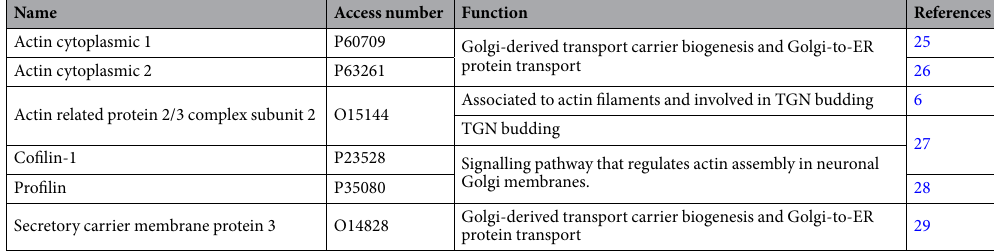
Table 1. F-actin components, effectors and regulators, with known functions at the Golgi complex, identified in the membrane fraction of purified granules from COS7-CgA cells. Identification was based on human sequences, as well as those of other mammalian species. Only proteins that were identified with one or more high scoring peptides from Mascot were considered to be true matches. “High scoring peptides” corresponded to peptides that were above the threshold in Mascot (P < 0.05) searches. The table shows a non-redundant list of the proteins and the reference to the Uniprot-access number used in database searches